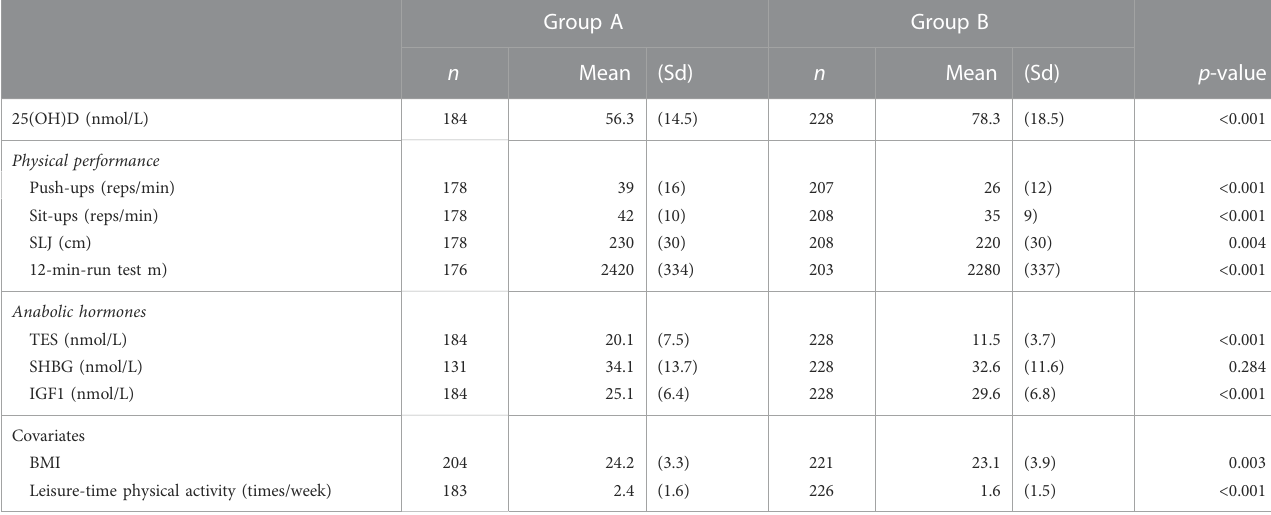
TABLE 1 Physical performance and anabolic hormone status and covariates between group A and B (N = 412). Standing long jump (SLJ), Muscular fi tness index (MFI); Testosterone (TES); Sex hormone binding globulin (SHBG); Insulin-like growth factor-1 (IGF-1), Body mass index (BMI). Differences between groups were tested using Independent Samples t -test.